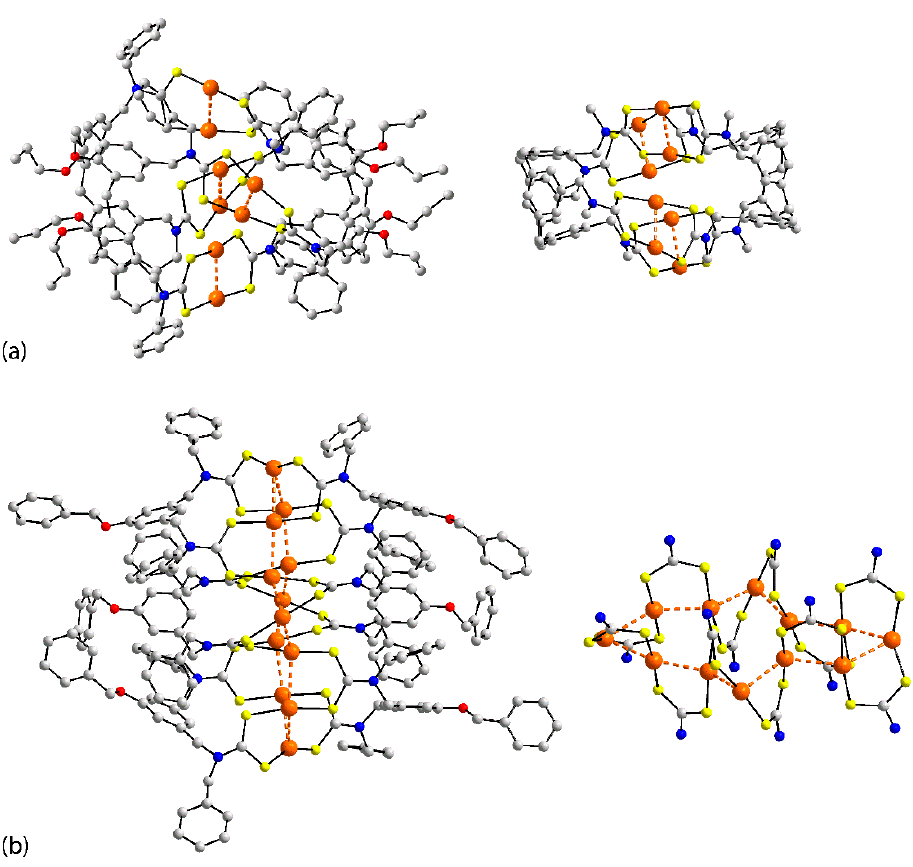
Figure 8. Molecular structures of ( a ) octa-nuclear Au 8 (L 13 ) 2 in the crystal of 33 and ( b ) dodeca-nuclear [Au 12 (L 14 ) 6 ] in 35 , with simplified versions shown on the right-hand side of each image. The basic repeating unit in the 16-gold atom cluster, octa-cationic [Au 16 (L 15 ) 4 ] 8+ , in the crystal of 36 [51] is a tetramer, that is, di-cationic {[(dppm)Au 2 ] 2 (L 15 )} 2+ , whereby each sulphur atom of each dithiocarbamate residue binds a gold atom. The pairs of gold atoms linked by each dithiocarbamate residue are also bridged by a dppm ligand, leading to eight-membered {–PCPAuSCSAu} rings. As observed above, when this mode of coordination is apparent, intramolecular aurophilic interactions are formed. In addition, six intermolecular aurophilic interactions are apparent, leading to two curved chains com- prising eight gold atoms each, as shown in Figure 9a. A 16-membered gold atom ring is not formed as the separation between two pairs of terminal gold atoms, of approximately 4.40 Å, is considered too long to represent a significant interaction between the atoms. The dithiocarbamate residues around the ring lie on opposite sides, as highlighted in the simplified view of Figure 9a. A similar molecular structure is found in the crystal of 37 , featuring [Au 16 (L 2 ) 4 ] 8+ octa-cations [52], as shown in Figure 9b. The mode of coordination of the L 2 di-anions and their alternating sequence of orientations around the girth of the molecule are as for 36 . A difference occurs as in this case; there are aurophilic interactions between each adjacent pair of gold atoms, so the 16 gold atoms define a closed ring with the shape of a bowl, as shown in Figure 9b.